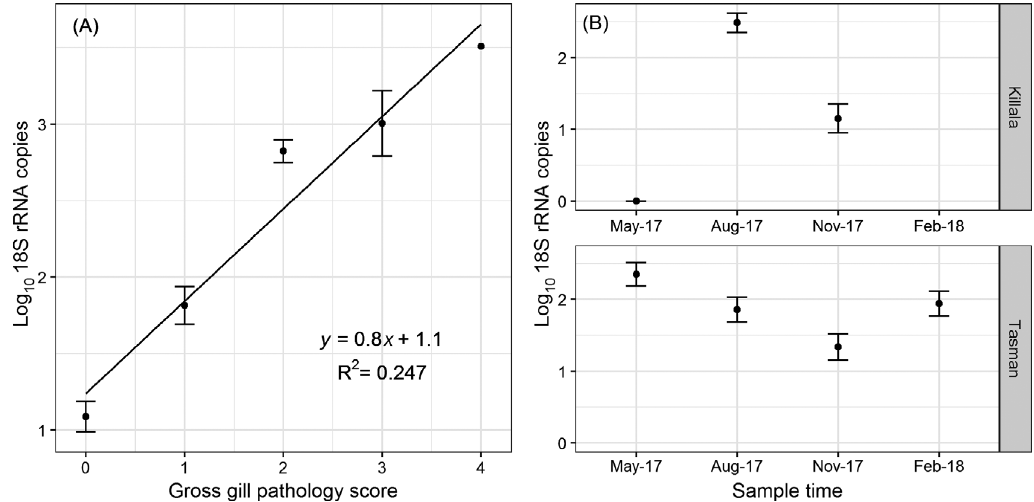
Fig. 3. Relative abundance of N. perurans on Atlantic salmon gills express as the mean ± SE of 18S rRNA copies with respect to (A) AGD gross gill pathology (gill score) quantified according to Taylor et al. (2009) and (B) farm site and sample time. The Feb 2018 Killala sampling is blank because no samples could be